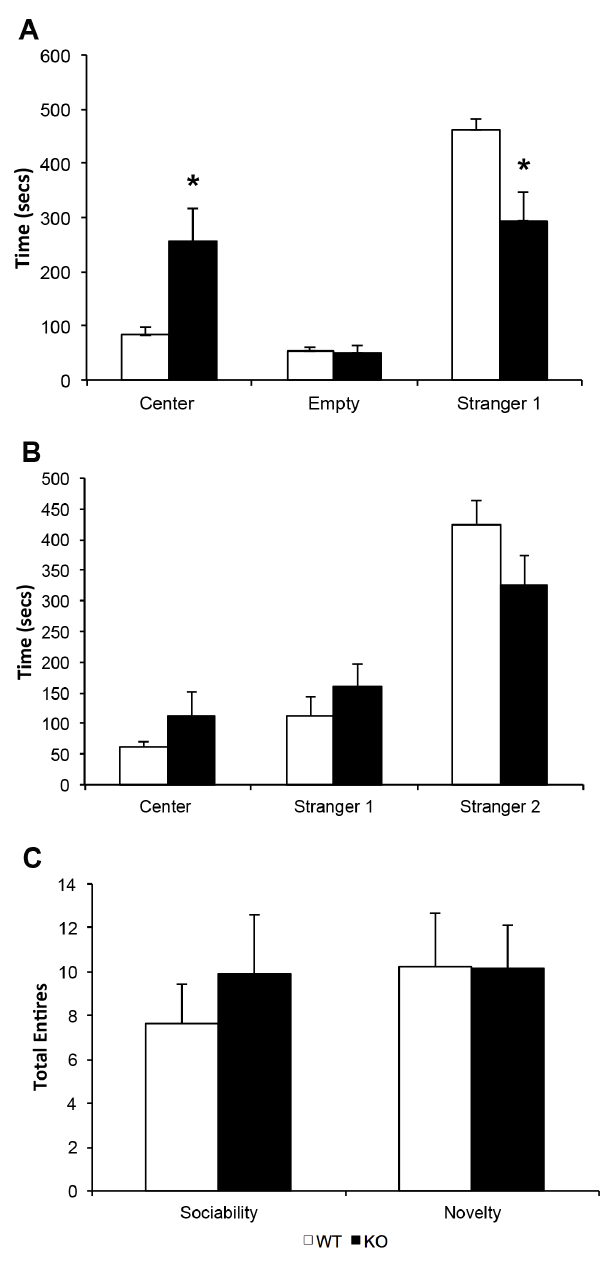
Figure 4. Social approach behavior in PTN KOs and WTs. (a) Time spent in the stranger 1 chamber, empty chamber, and center chamber during the sociability test; (b) time spent in the stranger 1 chamber, stranger 2 chamber, and center chamber during social novelty test; (c) total number of chamber entries made during the sociability and social novelty tests for KOs (n=11) and WTs (n=9). *p= , 0.05.